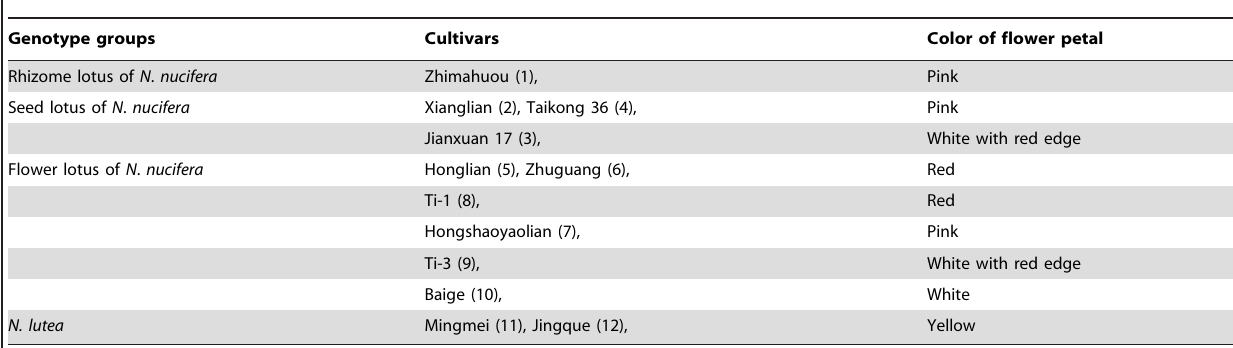
Table 1. Lotus cultivars used in this